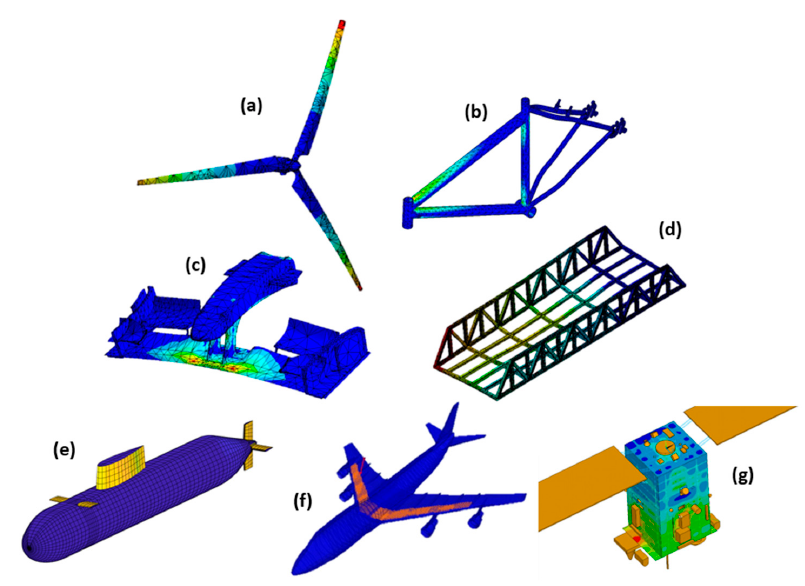
Figure 37. Some fields of FEM’s application to composites: ( a ) wind power, ( b ) sports, ( c ) automotive, ( d ) construction, ( e ) naval. Reproduced with Creative Common License [267], ( f ) aeronautics. Reproduced